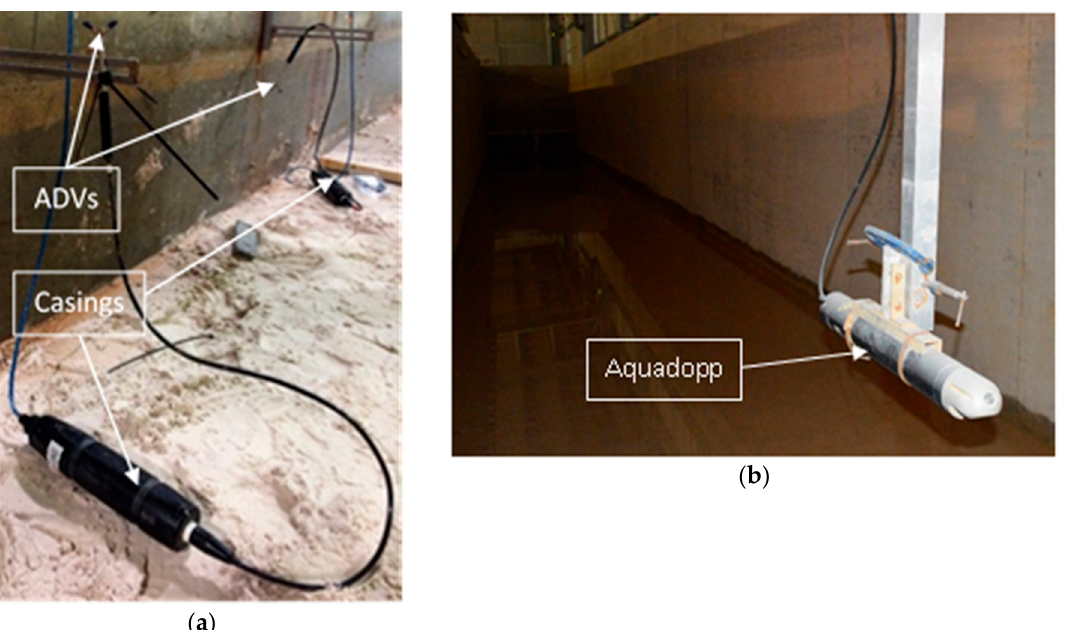
Figure 7. Instrumentation used for velocity measurements: ( a ) two ADVs placed above the sand pit; ( b ) down-facing Aquadopp profiler placed in the secondary flume channel. The Aquadopp vertical position was z = − 0.83 m for water depths 0.9 m and 1.2 m and z = − 0.91 m for water depths 1.5 m and 1.8 m.